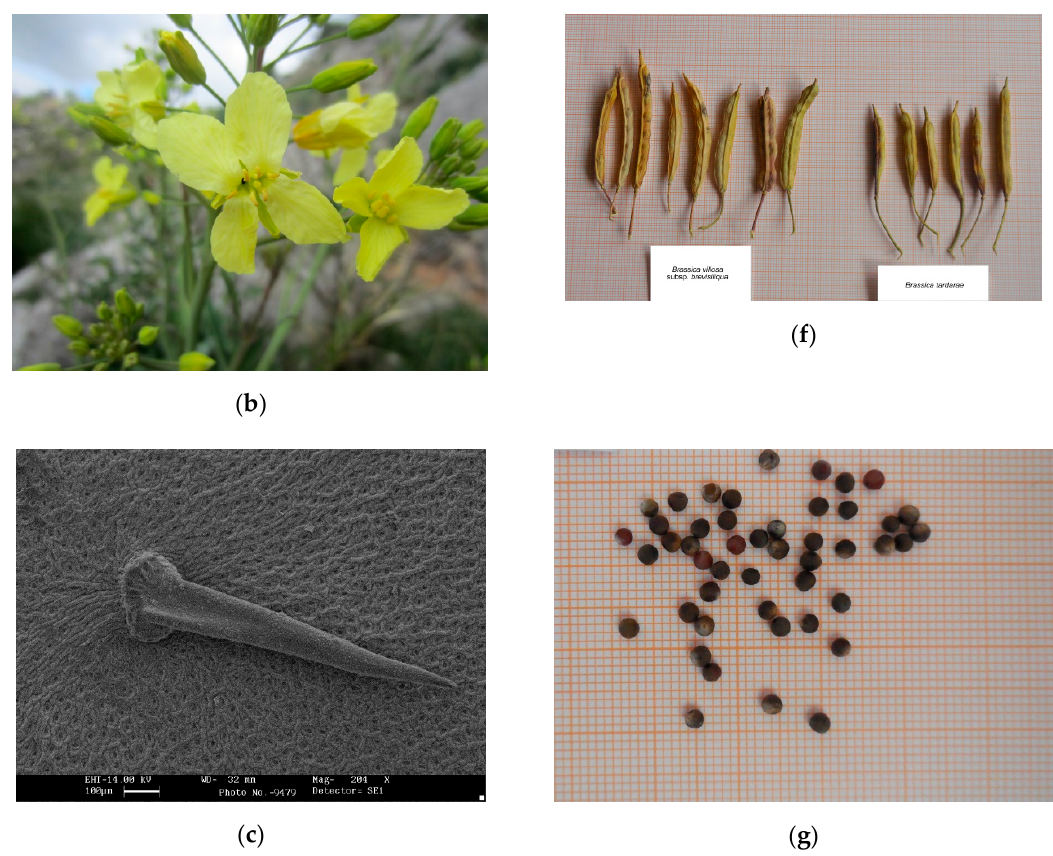
Figure 1. Habitus and morphology of Brassica tardarae : ( a ) a plant in its habitat; ( b ) detail of the flower; ( c ) SEM image of a bulbose hair on the blade of the leaf; ( d ) SEM image of pollen grains; ( e ) SEM image of seed surface; ( f ) comparison between siliquae of Brassica villosa subsp. brevisiliqua (on the left) and B. tardarae (on the right); ( g ) seeds of B. tardarae .